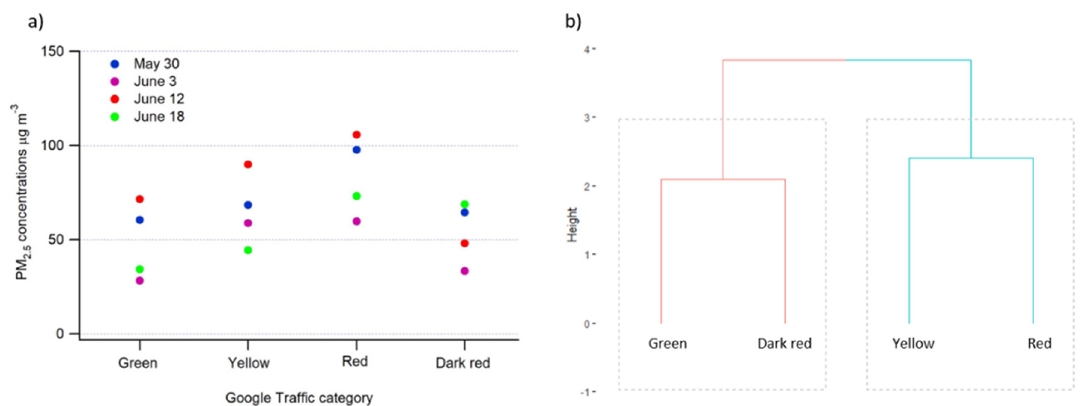
Figure 5. Google tra ffi c data analysis (Green—fast-flowing tra ffi c, Yellow—slower tra ffi c with more vehicles, Red—more congested tra ffi c, Dark red—the most congested or stopped tra ffi c): ( a ) Correlation analysis between average PM 2.5 concentrations and Google Tra ffi c categories; ( b ) Dendrogram from the cluster analysis of the tra ffi c based on PM 2.5 concentrations. The clustering splits the data of the four levels of tra ffi c into two most representative classes, showing that Green and Dark red can be grouped, whereas Yellow and Red compose another independent class. Height reflects the distance between the levels (the clusters are defined by choosing a cuto ff distance).